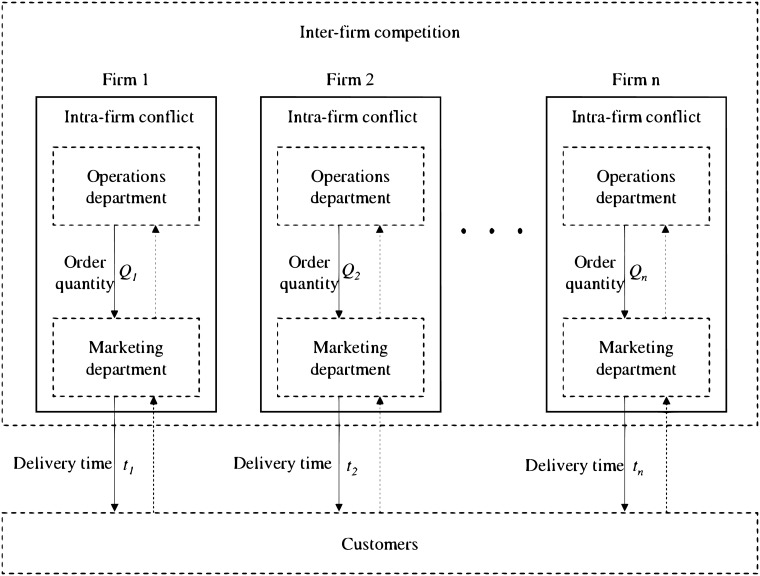
The structure of the proposed model.